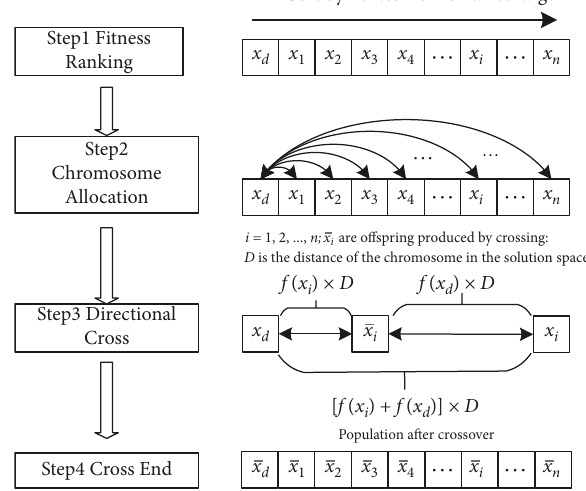
Figure 1: Schematic diagram of the directional crossover process.